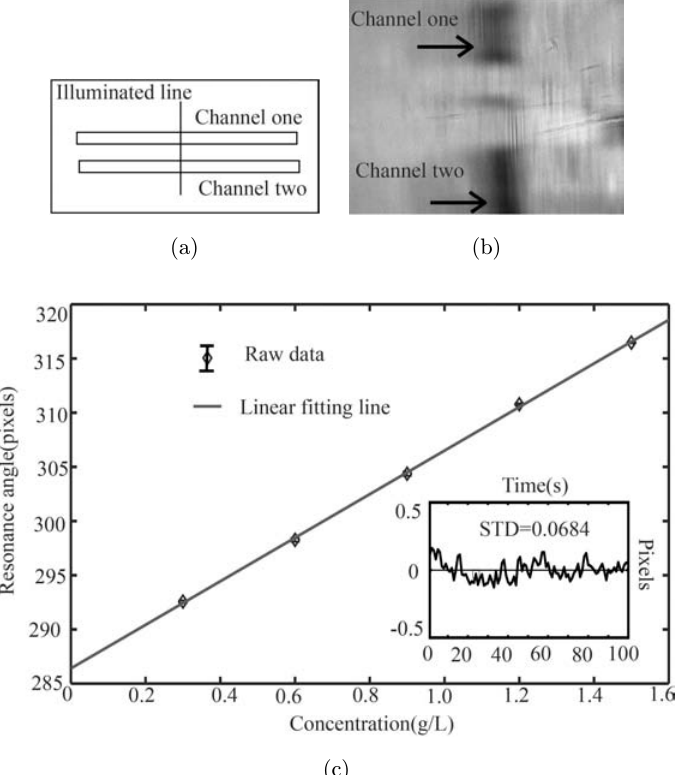
Fig. 3. Sensing characteristics of the system. (a) Structure of the two-channel system. (b) Re°ective image captured directly by a CCD. (c) Responses of the resonance angles to glucose solutions with di®erent concentrations (refractive indices). Error bar shows the standard deviation of 100